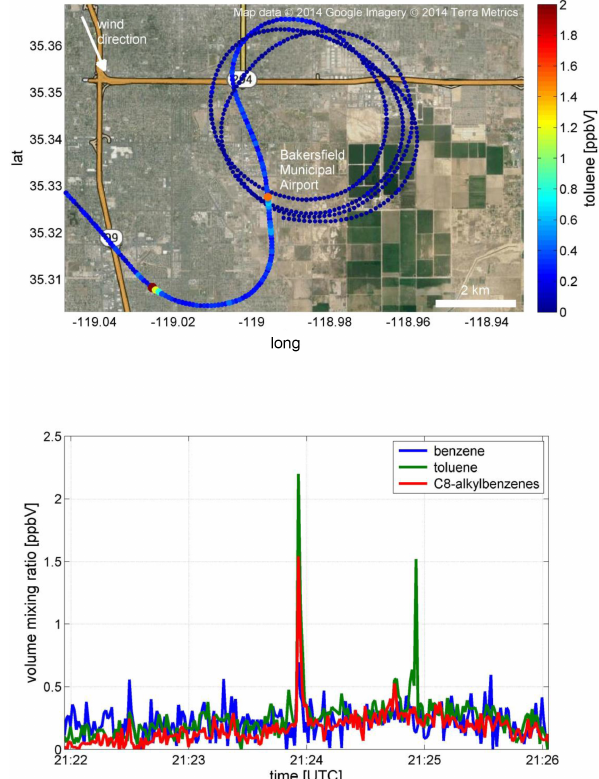
Figure 9. High-spatial-resolution data (top) of toluene during an urban overflight, obtained on 21 January 2013 over Bakersfield, CA, USA, and corresponding time series of benzene, toluene and C 8 - alkylbenzenes (xylenes plus